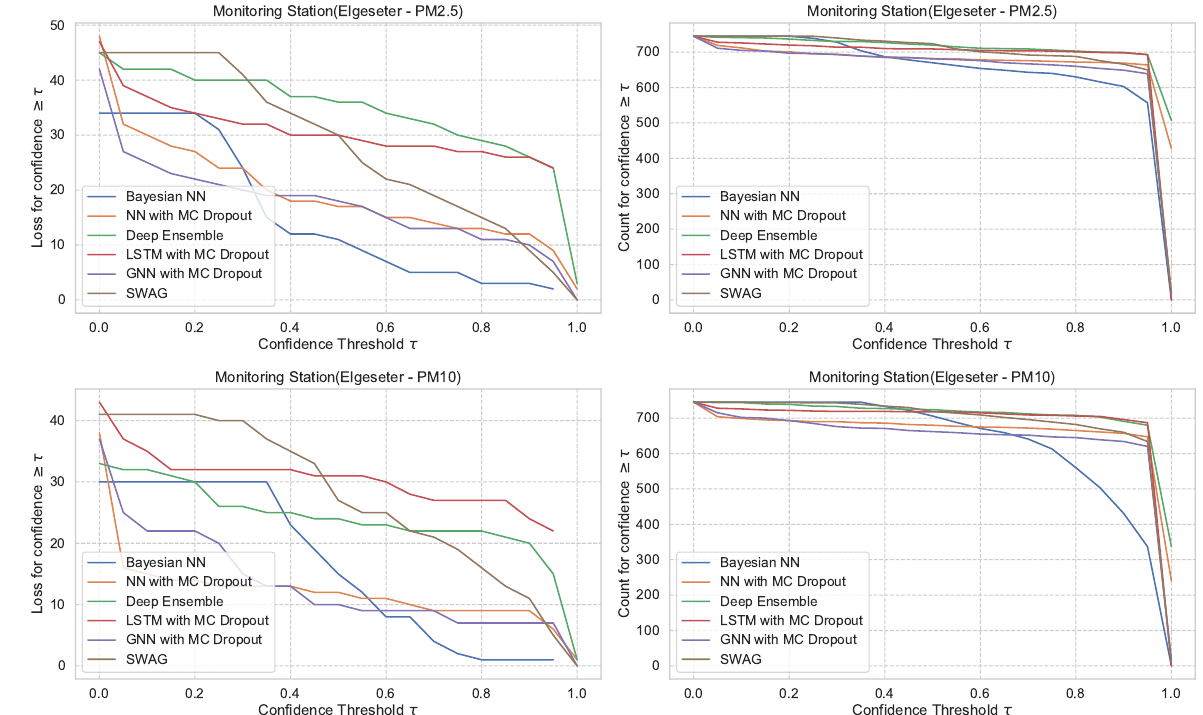
Figure 27. Comparison of confidence reliability for the selected probabilistic models in the threshold exceedance task. ( Left: ) loss versus confidence. ( Right: ) count versus confidence. The selected models produce are rational, which means the loss-vs-confidence curves are monotonically decreasing.